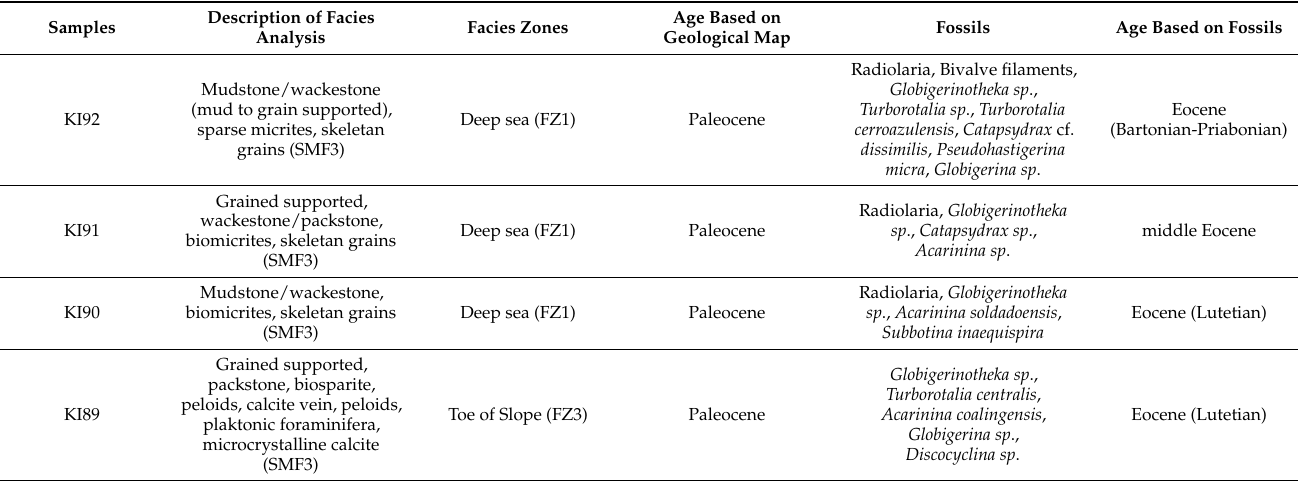
Table 1. Description of microfacies analysis of samples from Kastos Island and their age determination. Note the difference between the pre-existing age determinations and the new data of the present